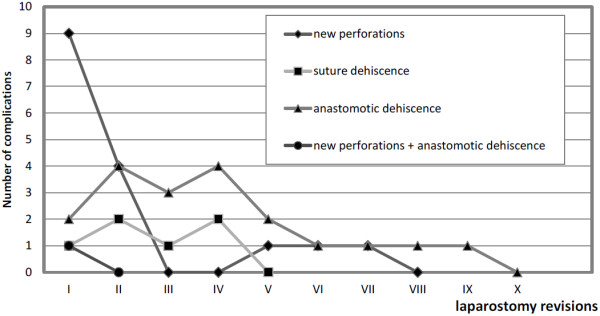
Complications observed at laparostomy revisions.